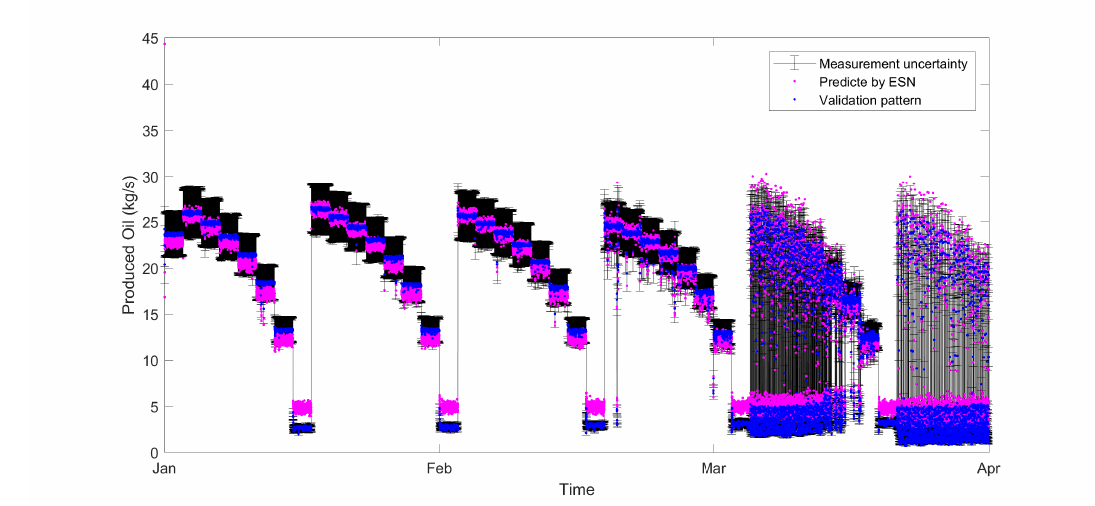
Figure 10. Validation of the 360-day network considering the data set of 3